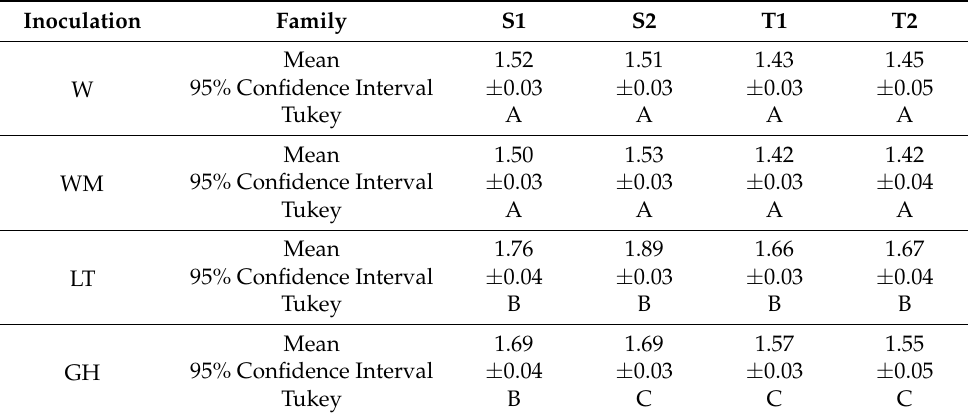
Table 11. Summary of occlusion length/seedling height by family and inoculation treatment. Inoculation Family S1 S2 T1 W